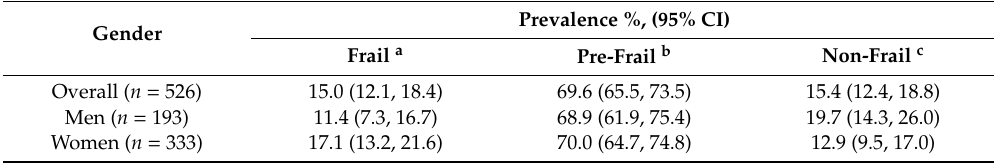
Table 1. Frailty prevalence (operationalized by Fried’s model) among early-old community dwellers population in the northern part of Thailand ( n =